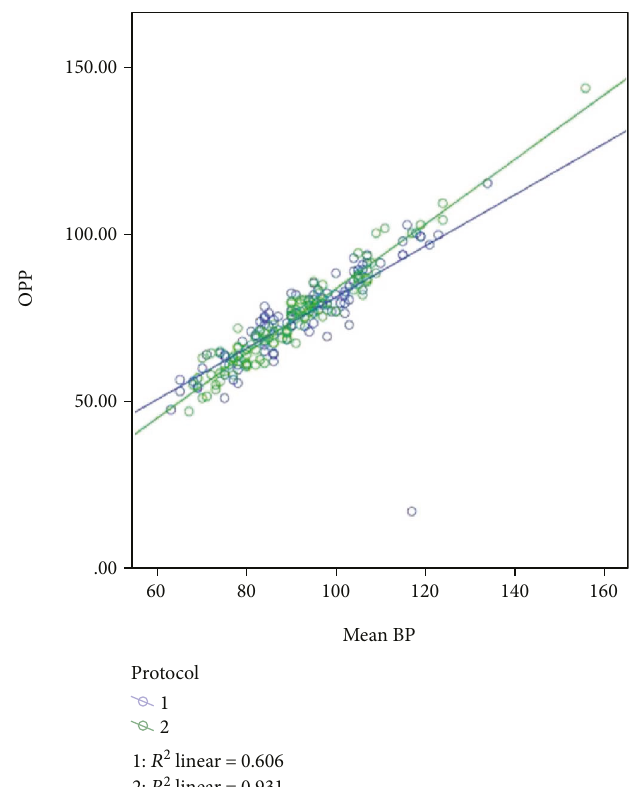
Figure 5: The correlation between OPP and MAP for both protocols is signi fi cant at the 0.01 level ( r = 0 871 , p = 0 001 ).